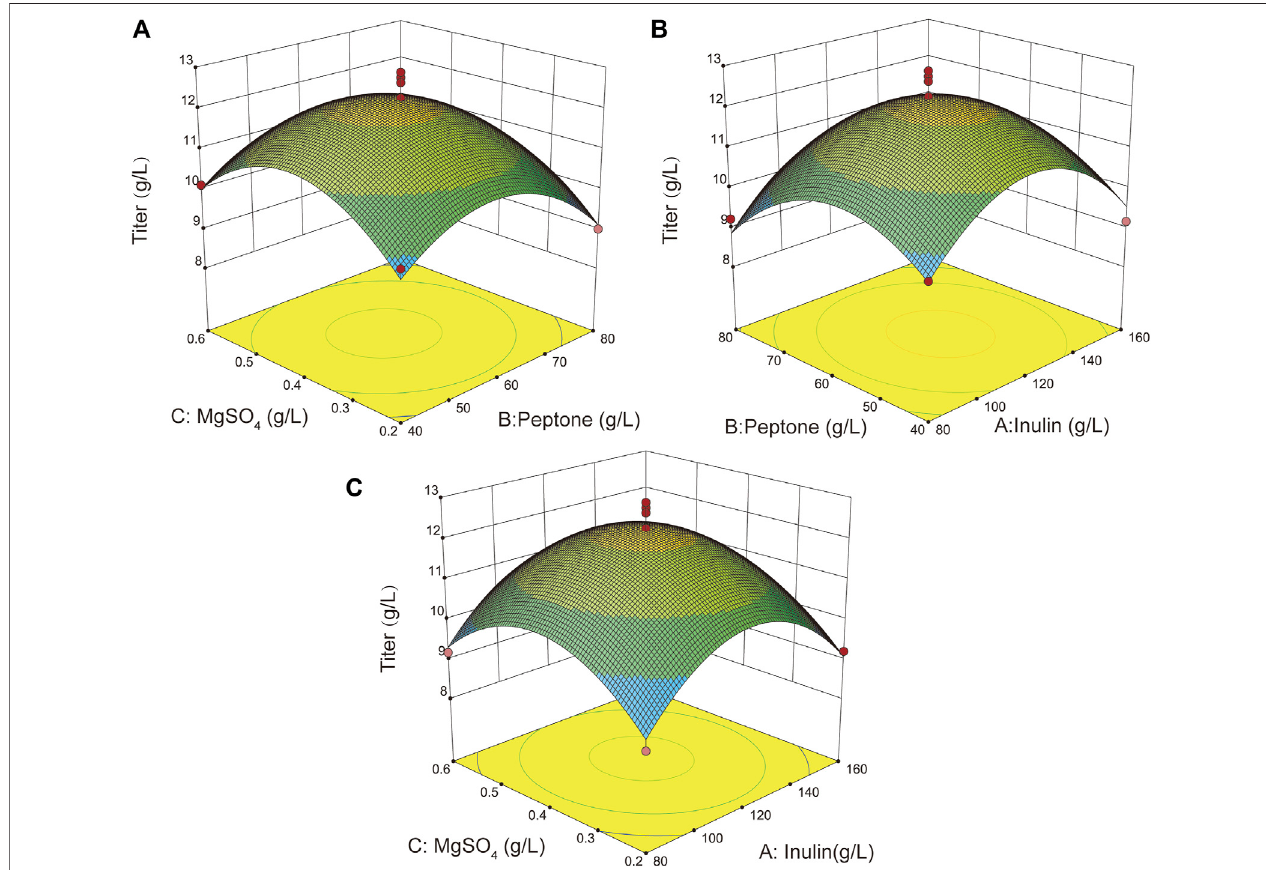
FIGURE 4 | The effect of different fermentation conditions on L -ornithine production and response surface optimization results. Three-factor and three-level response surface optimization for three major components (inulin, peptone, and MgSO 4 ) was done. (A) The response surface plot showed the effects of MgSO 4 and peptone on l-ornithine production. (B) The response surface plot showed the effects of inulin and peptone on L -ornithine production. (C) The response surface plot showed the effects of inulin and MgSO 4 on L-ornithine production.